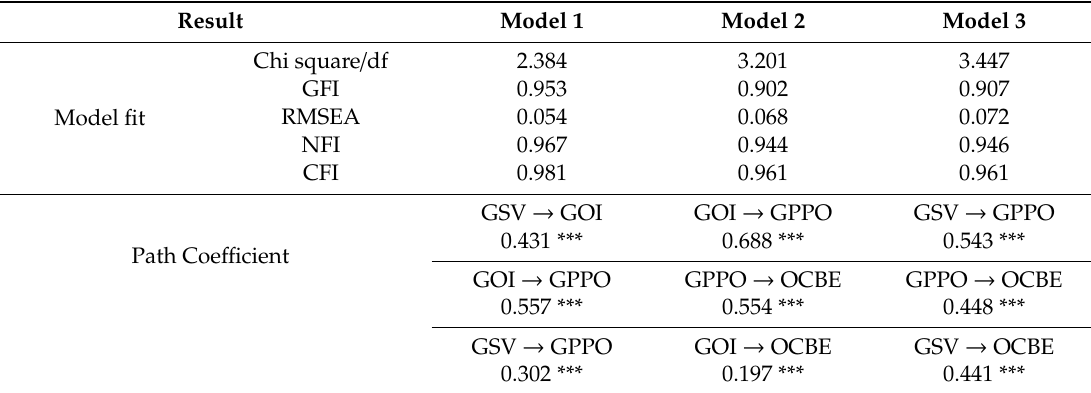
Table 5. Results of the structural mediation